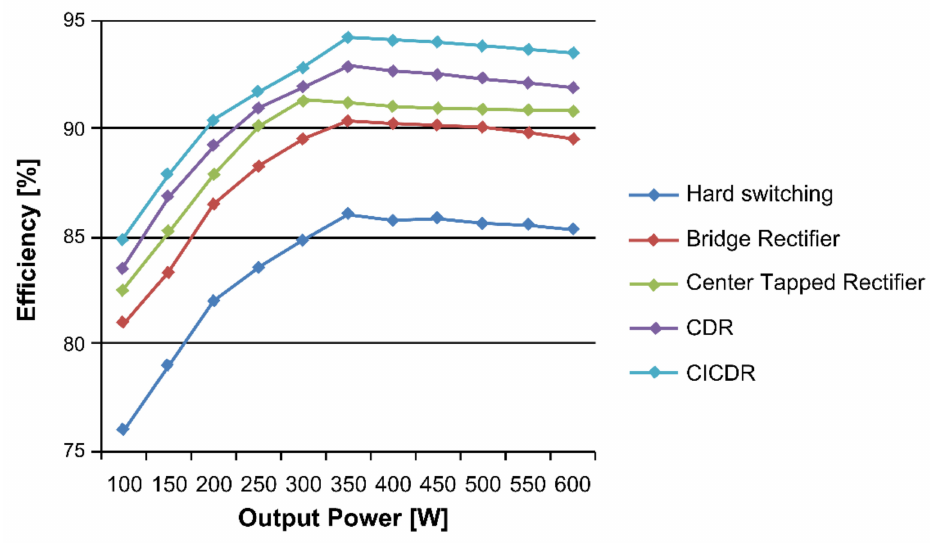
Figure 17. Waveforms of the primary side voltage and currents, v p , i p , of the transformer: ( a ) half-load condition; ( b ) full-load condition.